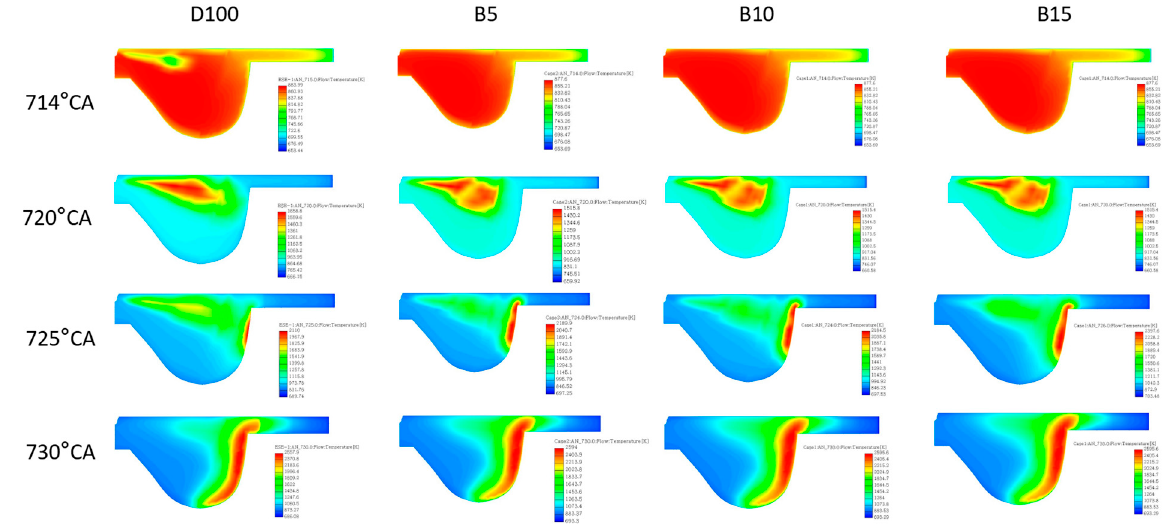
Figure 5. Cylinder temperature distribution field at different crank angles.